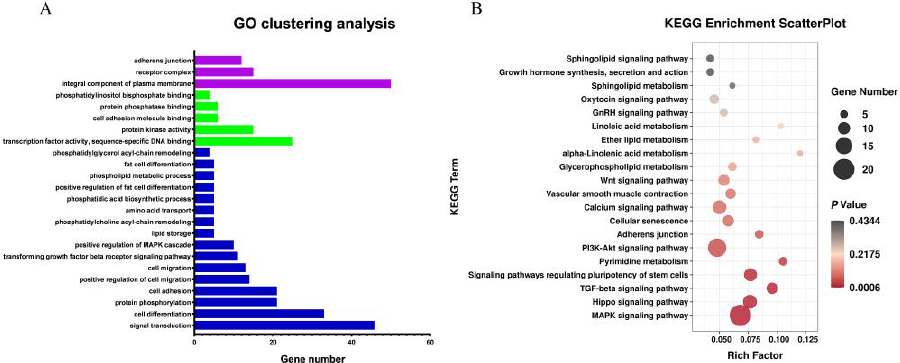
Figure 4. Analysis of Gene Ontology and KEGG Pathway Enrichment of target genes of differential lncRNAs. Note: ( A ) Gene Ontology of target genes of differential lncRNAs. Blue column represents BP, red column represents CC, and green column represents MF; ( B ) KEGG Pathway Enrichment of target genes of differential lncRNAs.